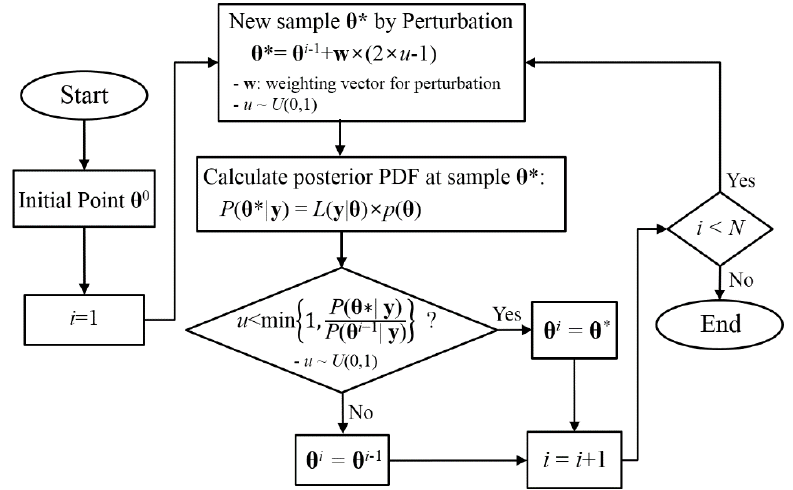
Figure 1. Flowchart of Metropolis-Hastings (M-H) algorithm for the parameter estimation using the Markov Chain Monte Carlo (MCMC) approach.